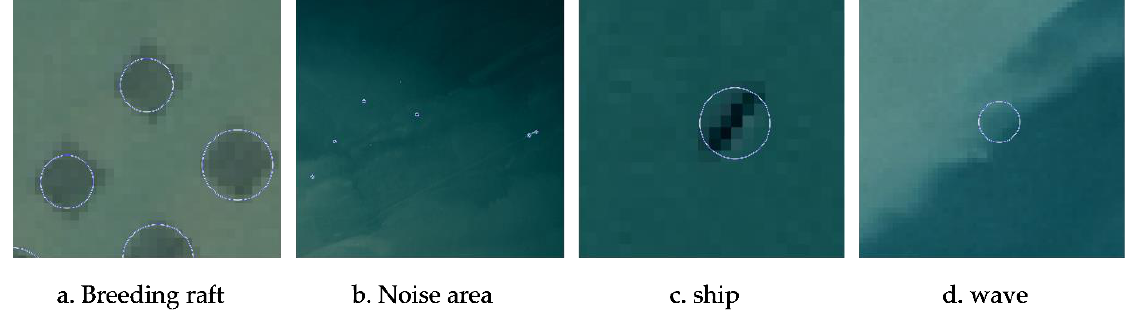
Figure 10. Local noise region: ( a ) identified aquaculture rafts; ( b ) noise identified on the sea surface; ( c , d ) noise caused by ships and waves.